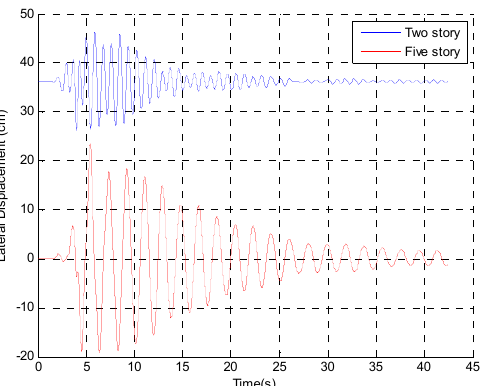
Figure 9. The lateral displacement time histories of buildings separated by the seismic gap of 36.14 cm.